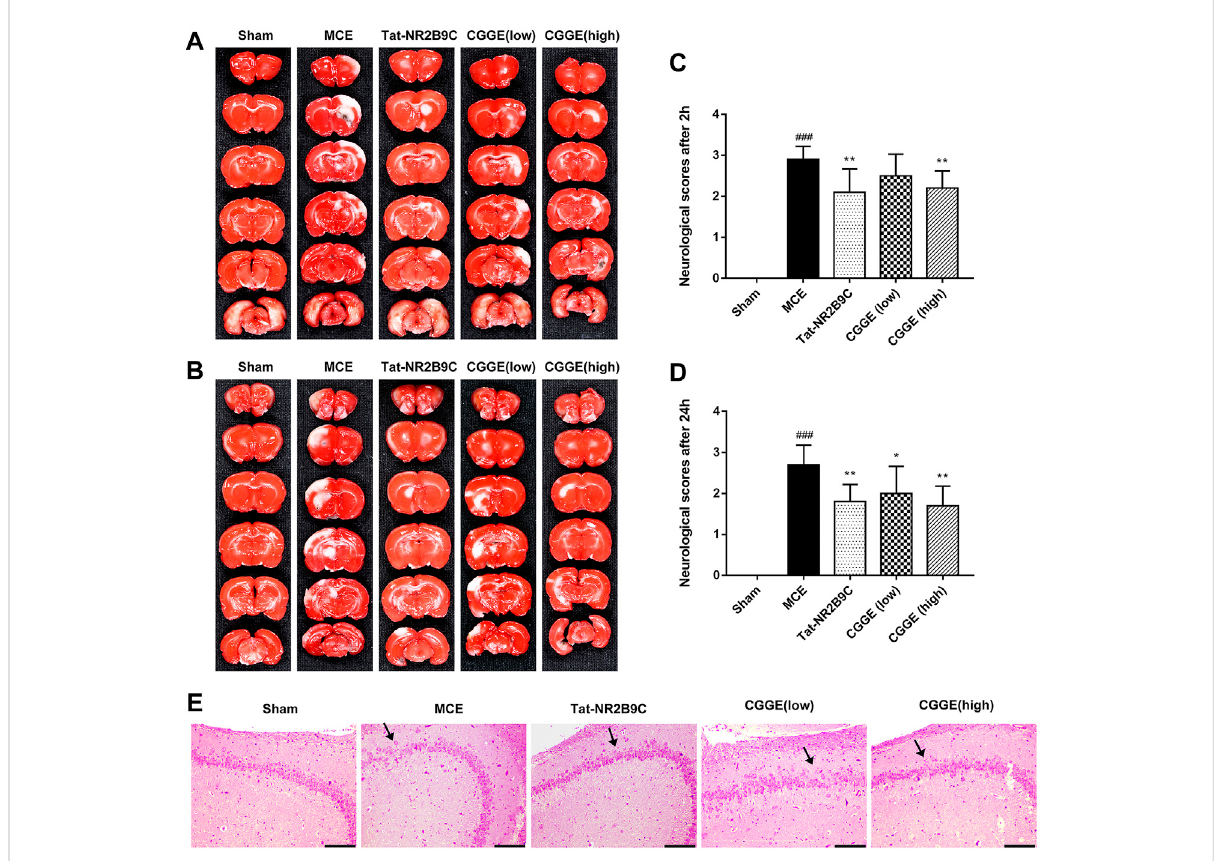
FIGURE 2 CGGEamelioratedMCE-inducedneurologicalde fi cits. (A,B) TTCstaining.Thepositiveside (A) andthenegativeside (B) ofthebrainslices.White color indicates “ infarcted area. ” (C,D) Neurological de fi cit scores after 2 h (C) and 24 h (D) . All data were expressed as mean ± SD, n = 10, ### p < 0.001 vs. Control group, ** p < 0.01, * p < 0.05 vs. Model group. (E) HE staining of the hippocampus, scale bar, 200 μ m (CA3 ×